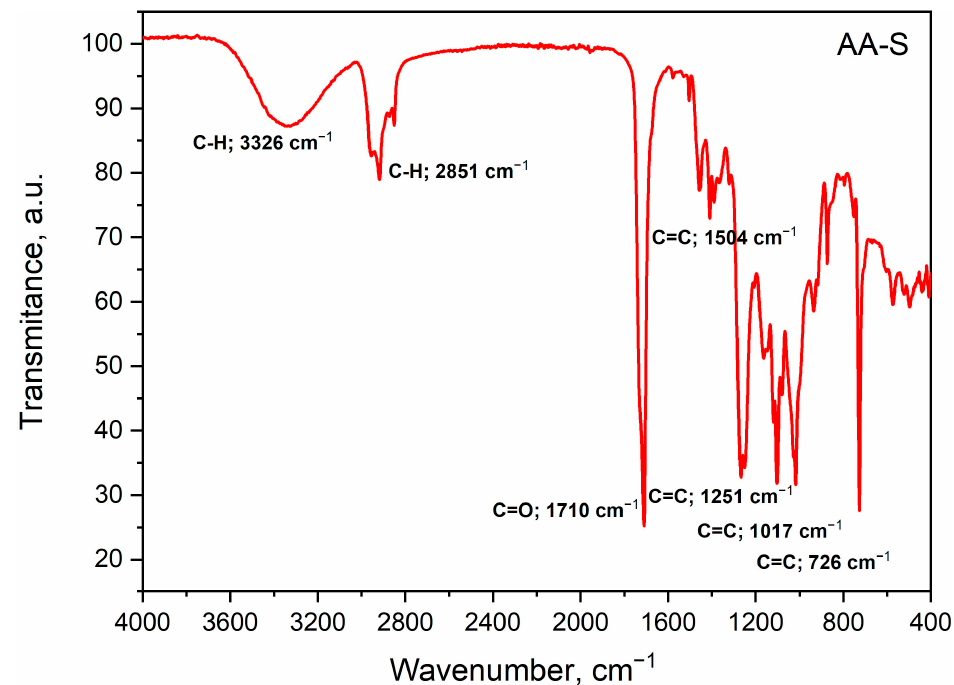
Figure 5. ATR FT-IR spectra of the AA-S film.